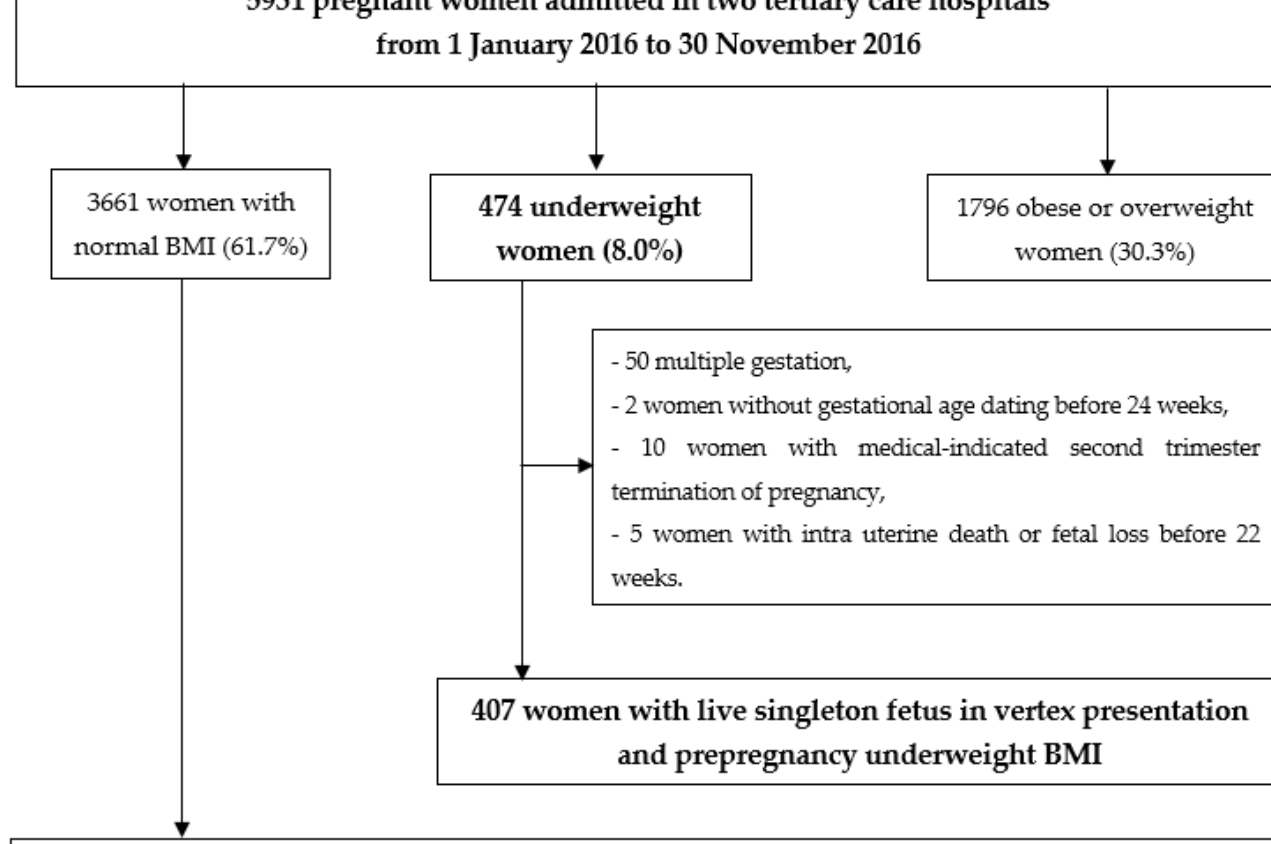
Figure 1. Study Figure 1. Study population.